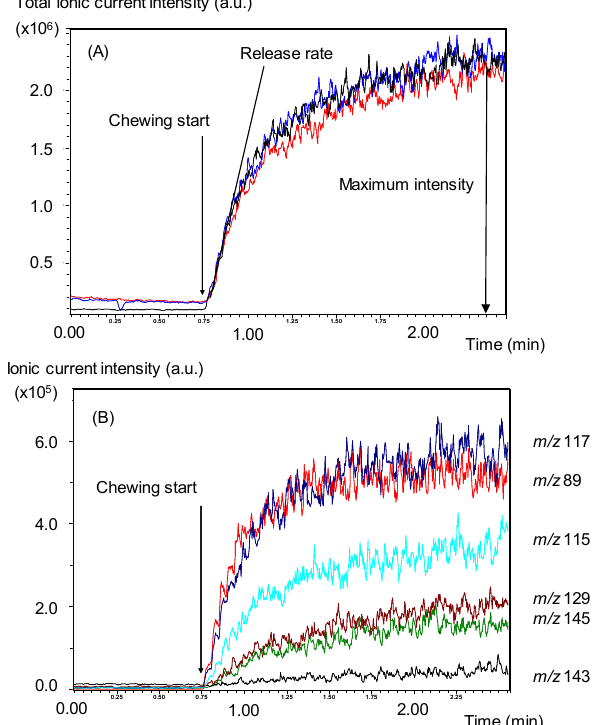
Figure 2. Example of in vitro temporal aroma compound release curves obtained by online coupling of the chewing simulator with the APCI-MS apparatus (3 replicates). ( A ) The total ionic current presented in ordinate is representative of the overall volatile compounds concentration in the gas phase according to the time. ( B ) Ionic current intensity for each detected ion in function of the chewing time. Conditions: initial volume of saliva: 1 mL; salivary flow rate: 1 mL/min; compression force: 25 DaN; shearing angle: 3°. Volatile compounds in lipoprotein matrices (µL/kg): butanoic acid (10); 2,3-butanedione (3); 2-heptanone (5); 2-nonanone (5); 3-octanone (5); ethyl hexanoate (5); ethyl butanoate (4); dimethyldisulphide (10). Ions: m/z 117 (ethylbutanoate); m/z 89 (butanoic acid); m/z 115 (2-heptanone); m/z 129 (3-octanone); m/z 145 (ethylhexanoate); m/z 143 (2-nonanone).